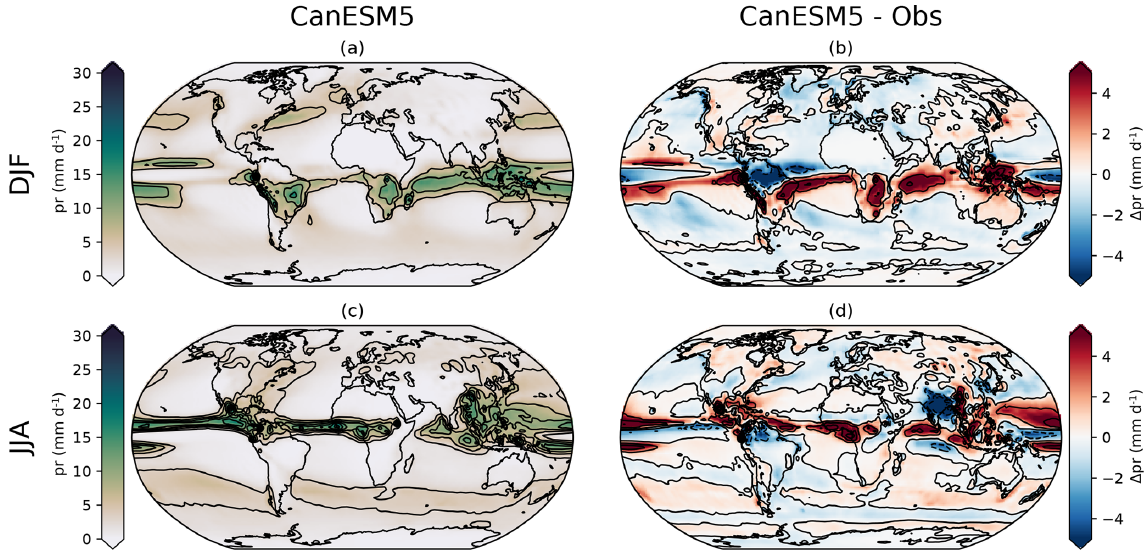
Figure 6. Climatologies of precipitation over 1981 to 2010 in CanESM5 (a, c) and their bias from the Global Precipitation Climatology Project (GPCP) over the same period (b, d) shown for the DJF (a, b) and JJA (c, d)